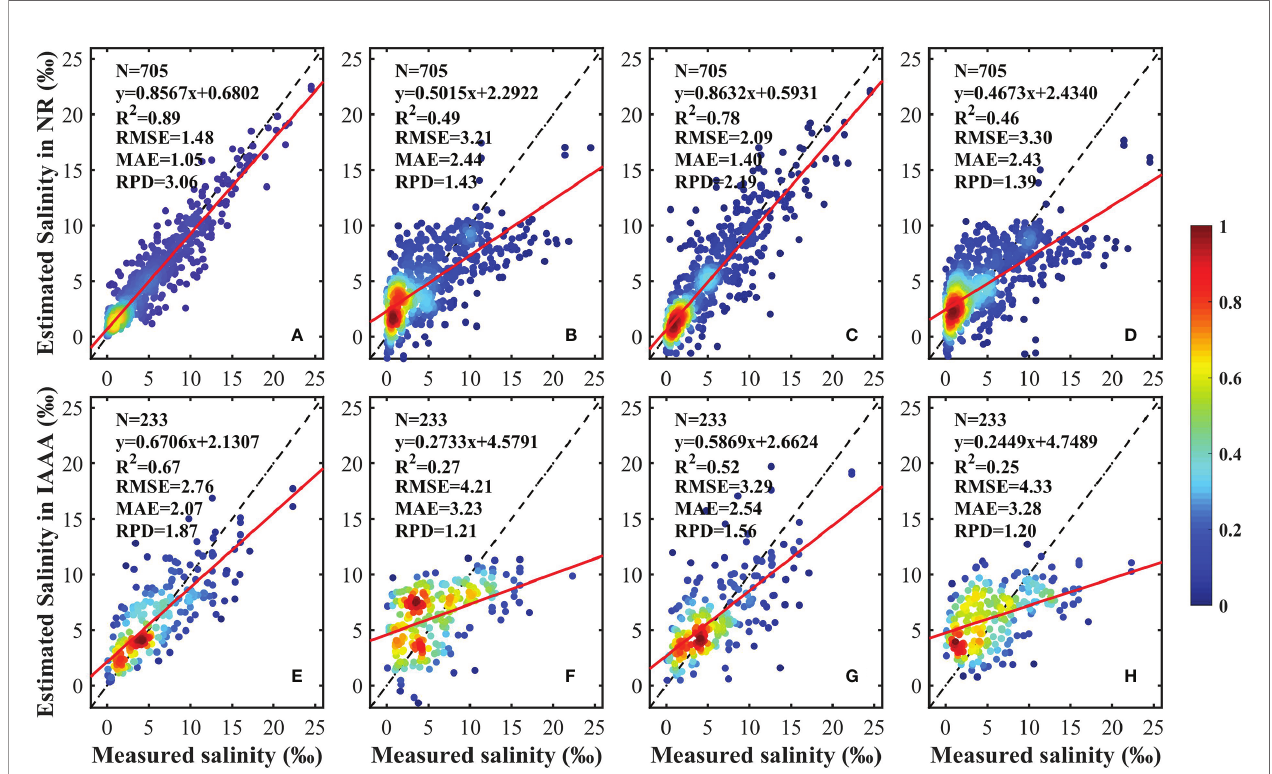
FIGURE 5 | Scatterplots of the model cross-validation results of the random forest model (A, E) , the multiple linear regression model (B, F) , the geographically weighted regression model (C, G) , and the partial least squares regression model (D, H) . The color represents the density of the point. The black dashed and solid lines represent the 1:1 line and the linear regression line,